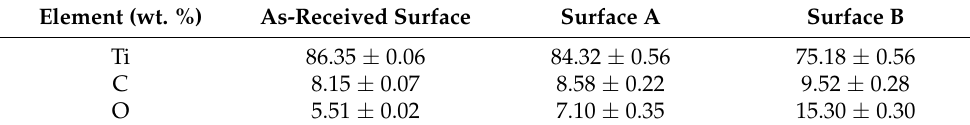
Table 3. Elemental composition of the as-received surface, Surface A and Surface B. Element (wt. %)